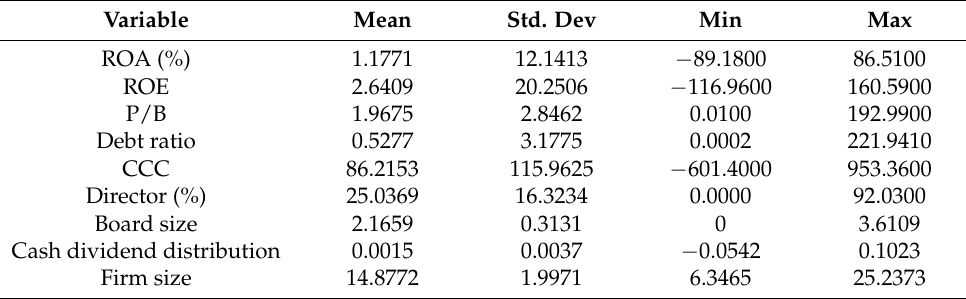
Table 1. Statistical results describing data of observed